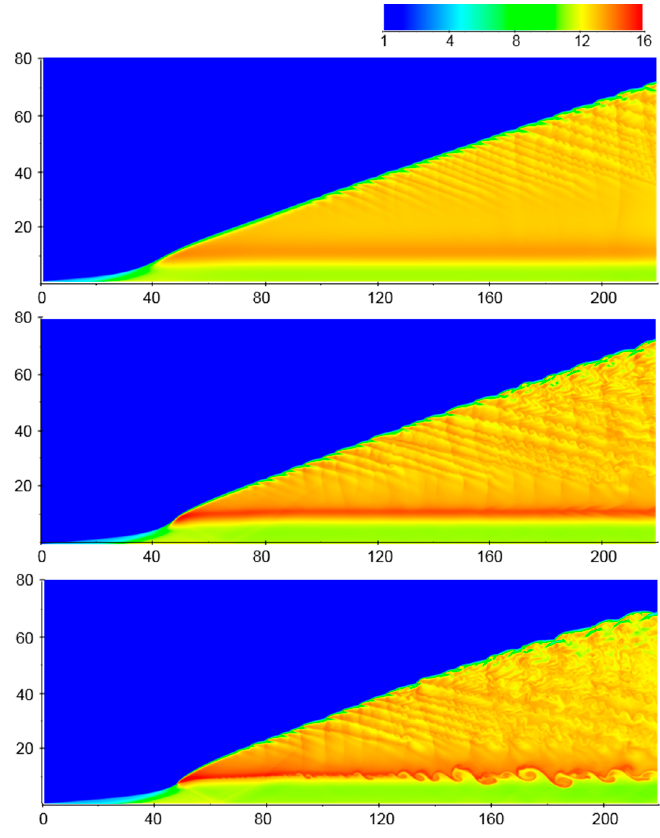
Figure 8. Temperature contours with M 0 = 10 and θ = 26 ◦ for E a = 20 (upper) 24 (middle) and 30 (lower). The corresponding pre-exponential constant k values are 16.6, 31.0, and 81.1, respectively.